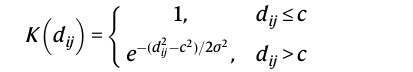
electrostatic interactions were evaluated with the smooth PME algorithm 63 with a grid space of 1Å. For short-range non-bonded interactions, a cut-off of 12 Å with a switching function at 10.0Å was used. The integration time step was 2 fs.